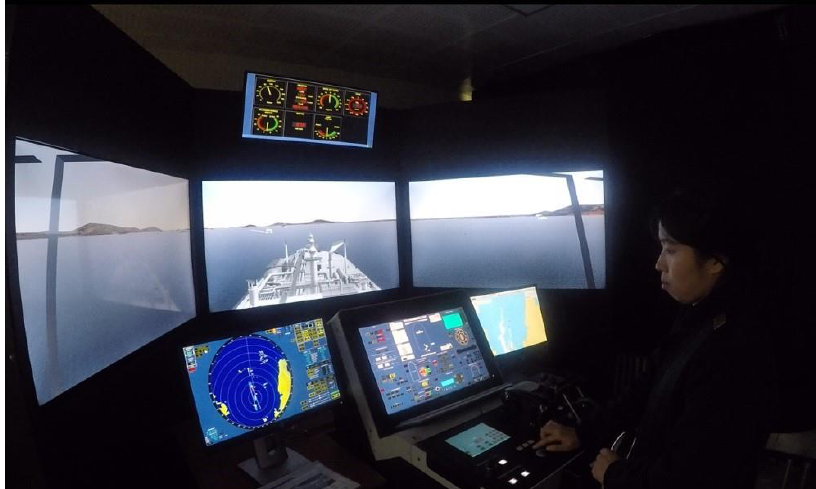
Figure 3. Snapshot of a scene in the simulation experiment.